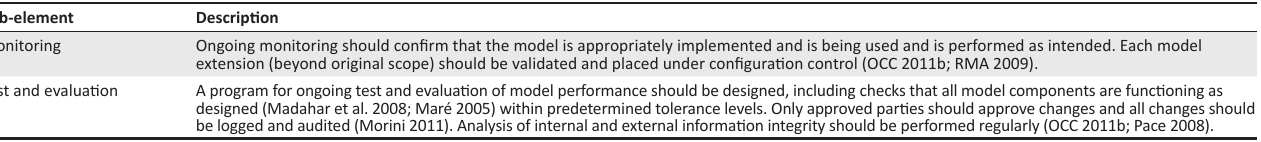
TABLE 2: Process verification and ongoing monitoring.